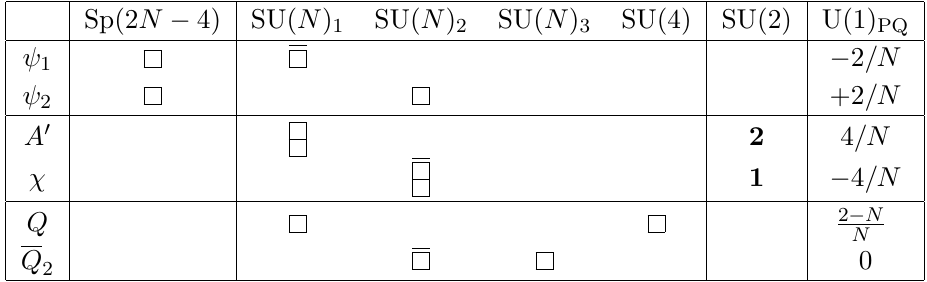
Table 4 . A subset of the matter (cid:12)elds in the Sp(2 N 4) model are shown with their Peccei-Quinn (cid:0) charges. All of the non-Abelian groups except for SU(2) are gauged. combination of A and A remains massless, which we de(cid:12)ne as A 0 1 0 2